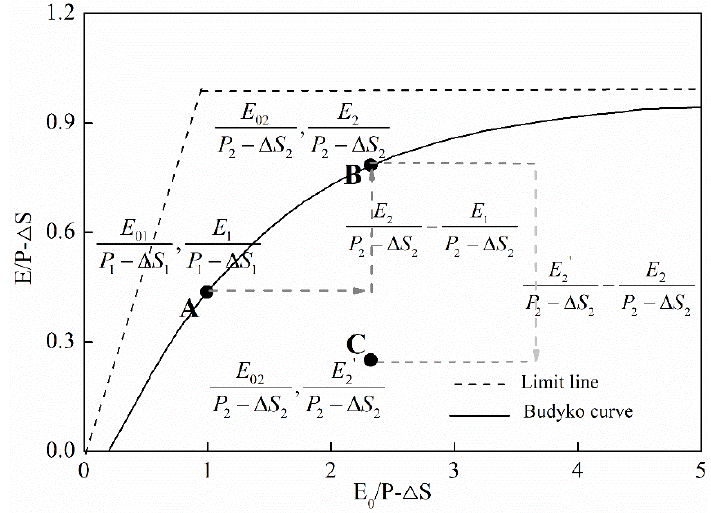
Figure 2. Schematic of extended Budyko decomposition method to quantify the climate and underlying surface changes impacts on streamflow change at seasonal scale. Changes from Point A to B indicate the relation between evaporation ratio and climate condition under the influence of climate change. Changes from Point A to C indicate the relation between evaporation ratio and climate condition under joint influences from climate and underlying surfaces changes